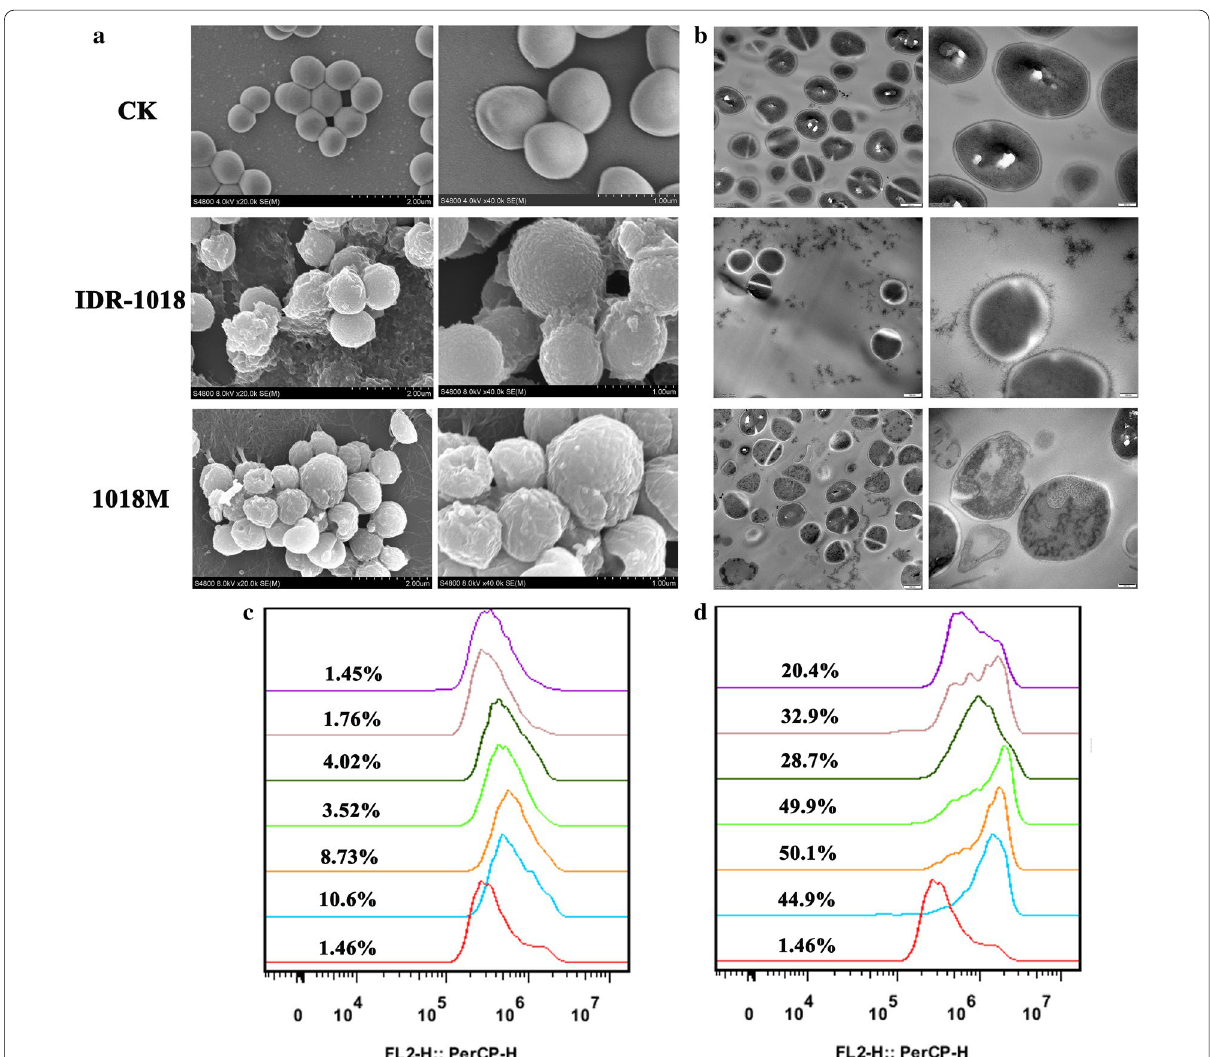
Fig. 3 Effects of 1018M on cell wall and membrane. a–b Scanning electron microscopy ( a ) and transmission electron microscopy ( b ) analysis of MRSA ATCC43300 cells treated with IDR-1018 and 1018M. c – d Flow cytometric analysis of PI-staining in MRSA ATCC43300 cells treated with 2 or × 4 MIC IDR-1018 ( c ) and 1018M ( d ) for 30 or 120 min, respectively. Red line: no peptide, negative control; Blue line: treatment with 1 MIC peptides × × for 30 min; Orange line: treatment with 2 MIC peptides for 30 min; Green line: treatment with 4 MIC peptides for 30 min. black line: treatment × × with 1 MIC peptides for 120 min; brown line: treatment with 2 MIC peptides for 120 min; purple line: treatment with 4 MIC peptides for 120 × × ×